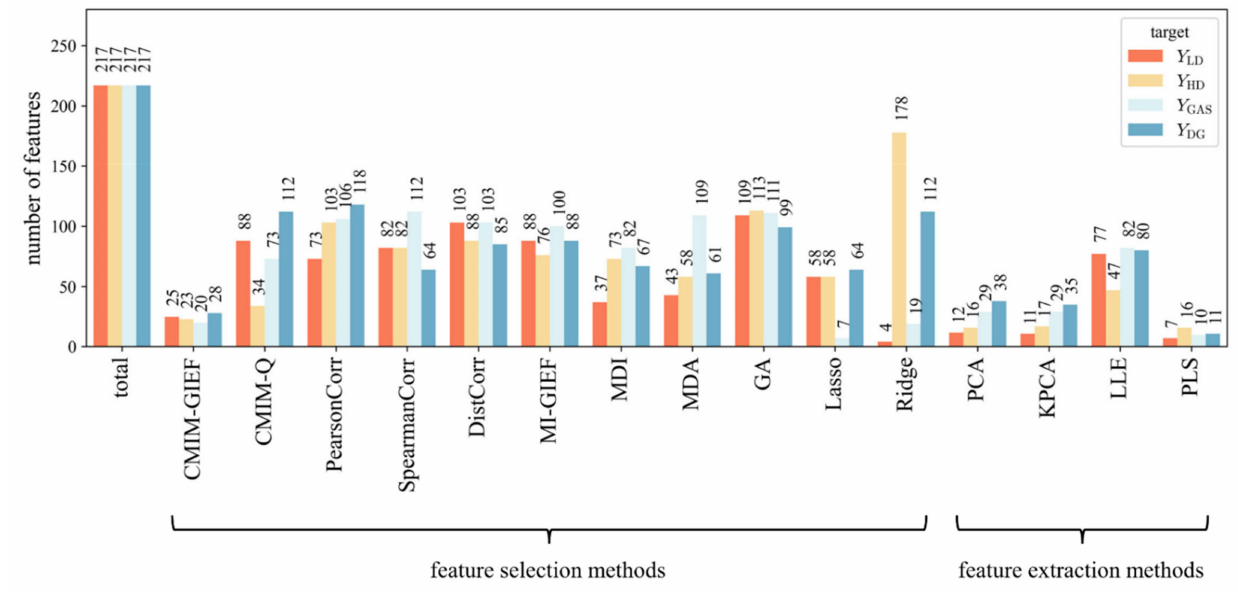
Figure 6. Comparison of feature numbers obtained by different data-dimensionality reduction